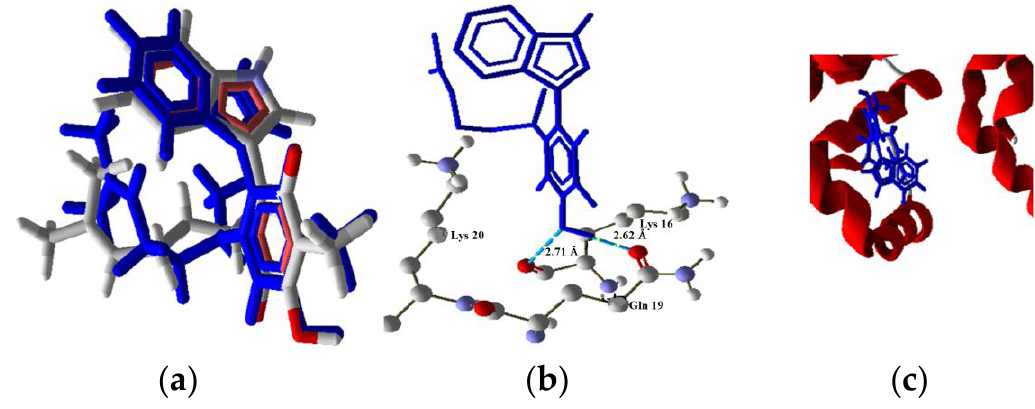
Figure 11 . Model of interaction of 2 with Bim. ( a ) Poor overlapping of the ligand (blue) and the pose (red). ( b ) Interaction of 2 and Bim complex, two H bonds with protein residues. ( c ) Secondary structure, ligand (blue) in the middle of the two monomers.